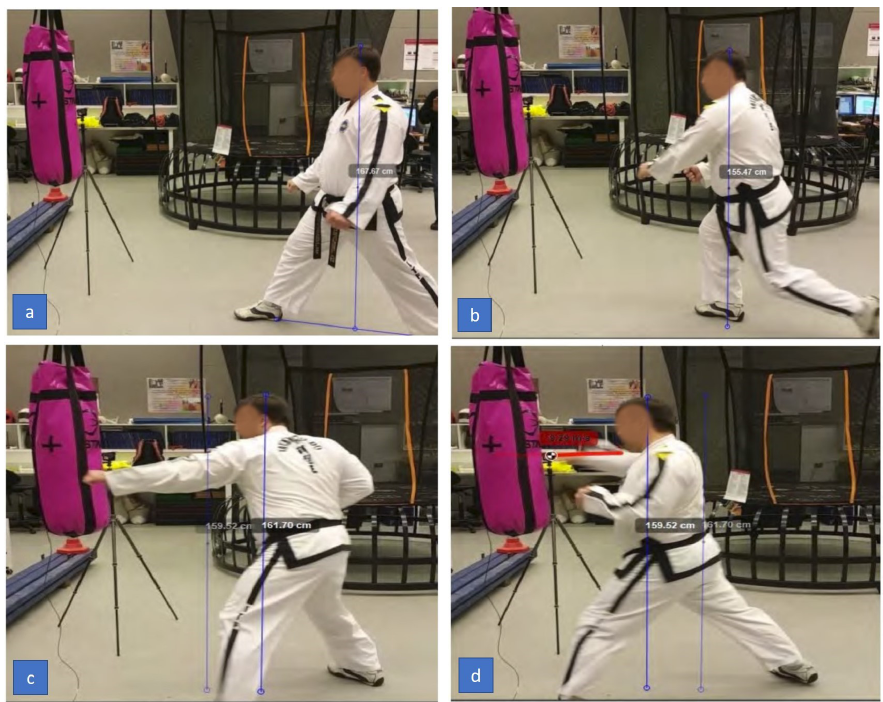
Figure 9. Taekwondo reverse-step punch motion ( a ) preparation phase ( b ) forward step ( c ) retracting punching hand ( d ) striking with punching hand and drawing opposite hand